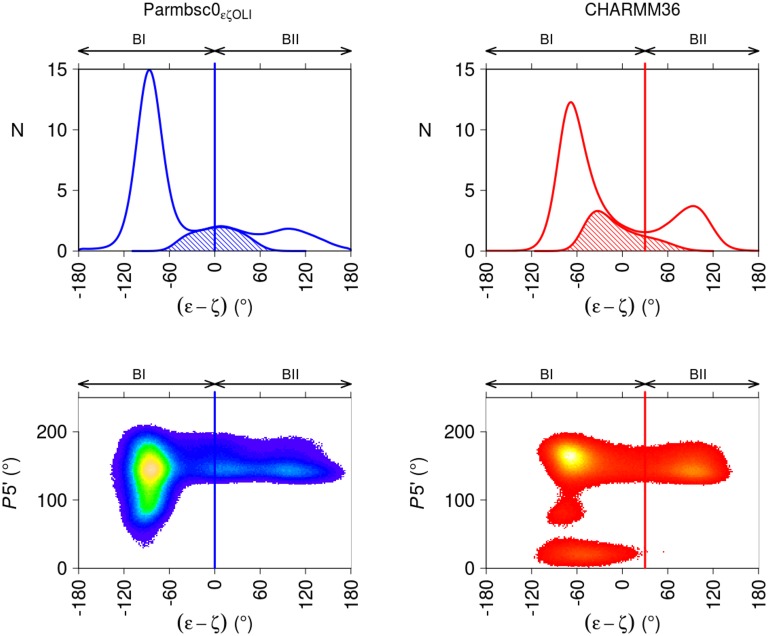
Distribution of backbone (ε-ζ) values and 5’ sugar behavior in MD snapshots.Top panels: the frequencies (N) of (ε-ζ) values were extracted from P-MDs (left panel, blue line) and C-MDs (right panels, red line) snapshots. The BI and BII regions are indicated, in accordance with the analysis presented in the main text. The hashed regions correspond to the distribution of ε/ζ:trans/trans, the categorization of which is ambiguous with regard to BI or BII. Bottom panels: pseudorotation phase angle (P) of the 5’ sugar puckers as a function of (ε-ζ) values (°), extracted from P-MDs (left panel) and C-MDs (right panel). The sugar ring conformations were in north (pseudorotation phase angle 0 to 50°), east (50 to 120°) or south (120 to 220°). The (ε-ζ) region assigned to BII does not contain 5’ north sugars. The color gradient is indicative of the density, with the highest densities in yellow. The vertical lines indicate the (ε-ζ) values used here to separate BI from BII in P- (blue lines) and C-MDs (red lines).